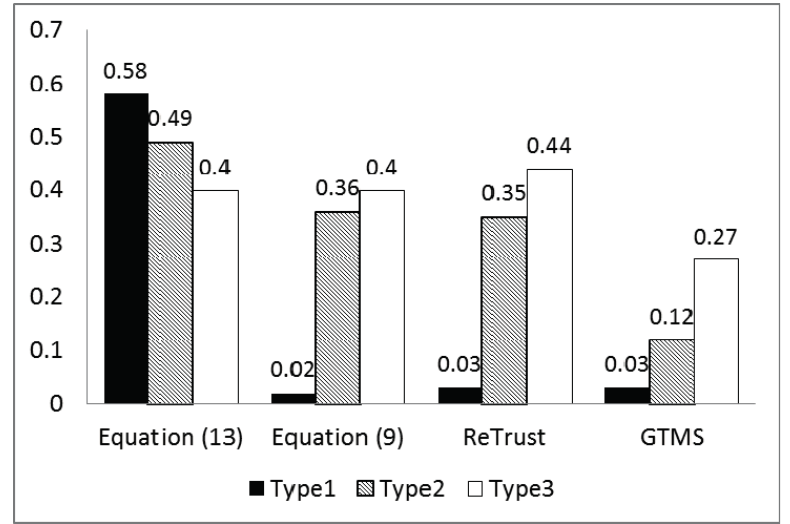
Figure 13. On-off attack detection